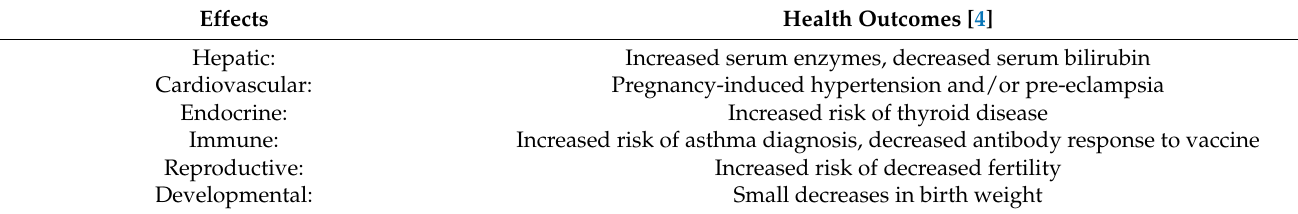
Table 1. ATSDR General Health Outcomes and Effects among PFOA, PFOS, and 12 other PFAS.